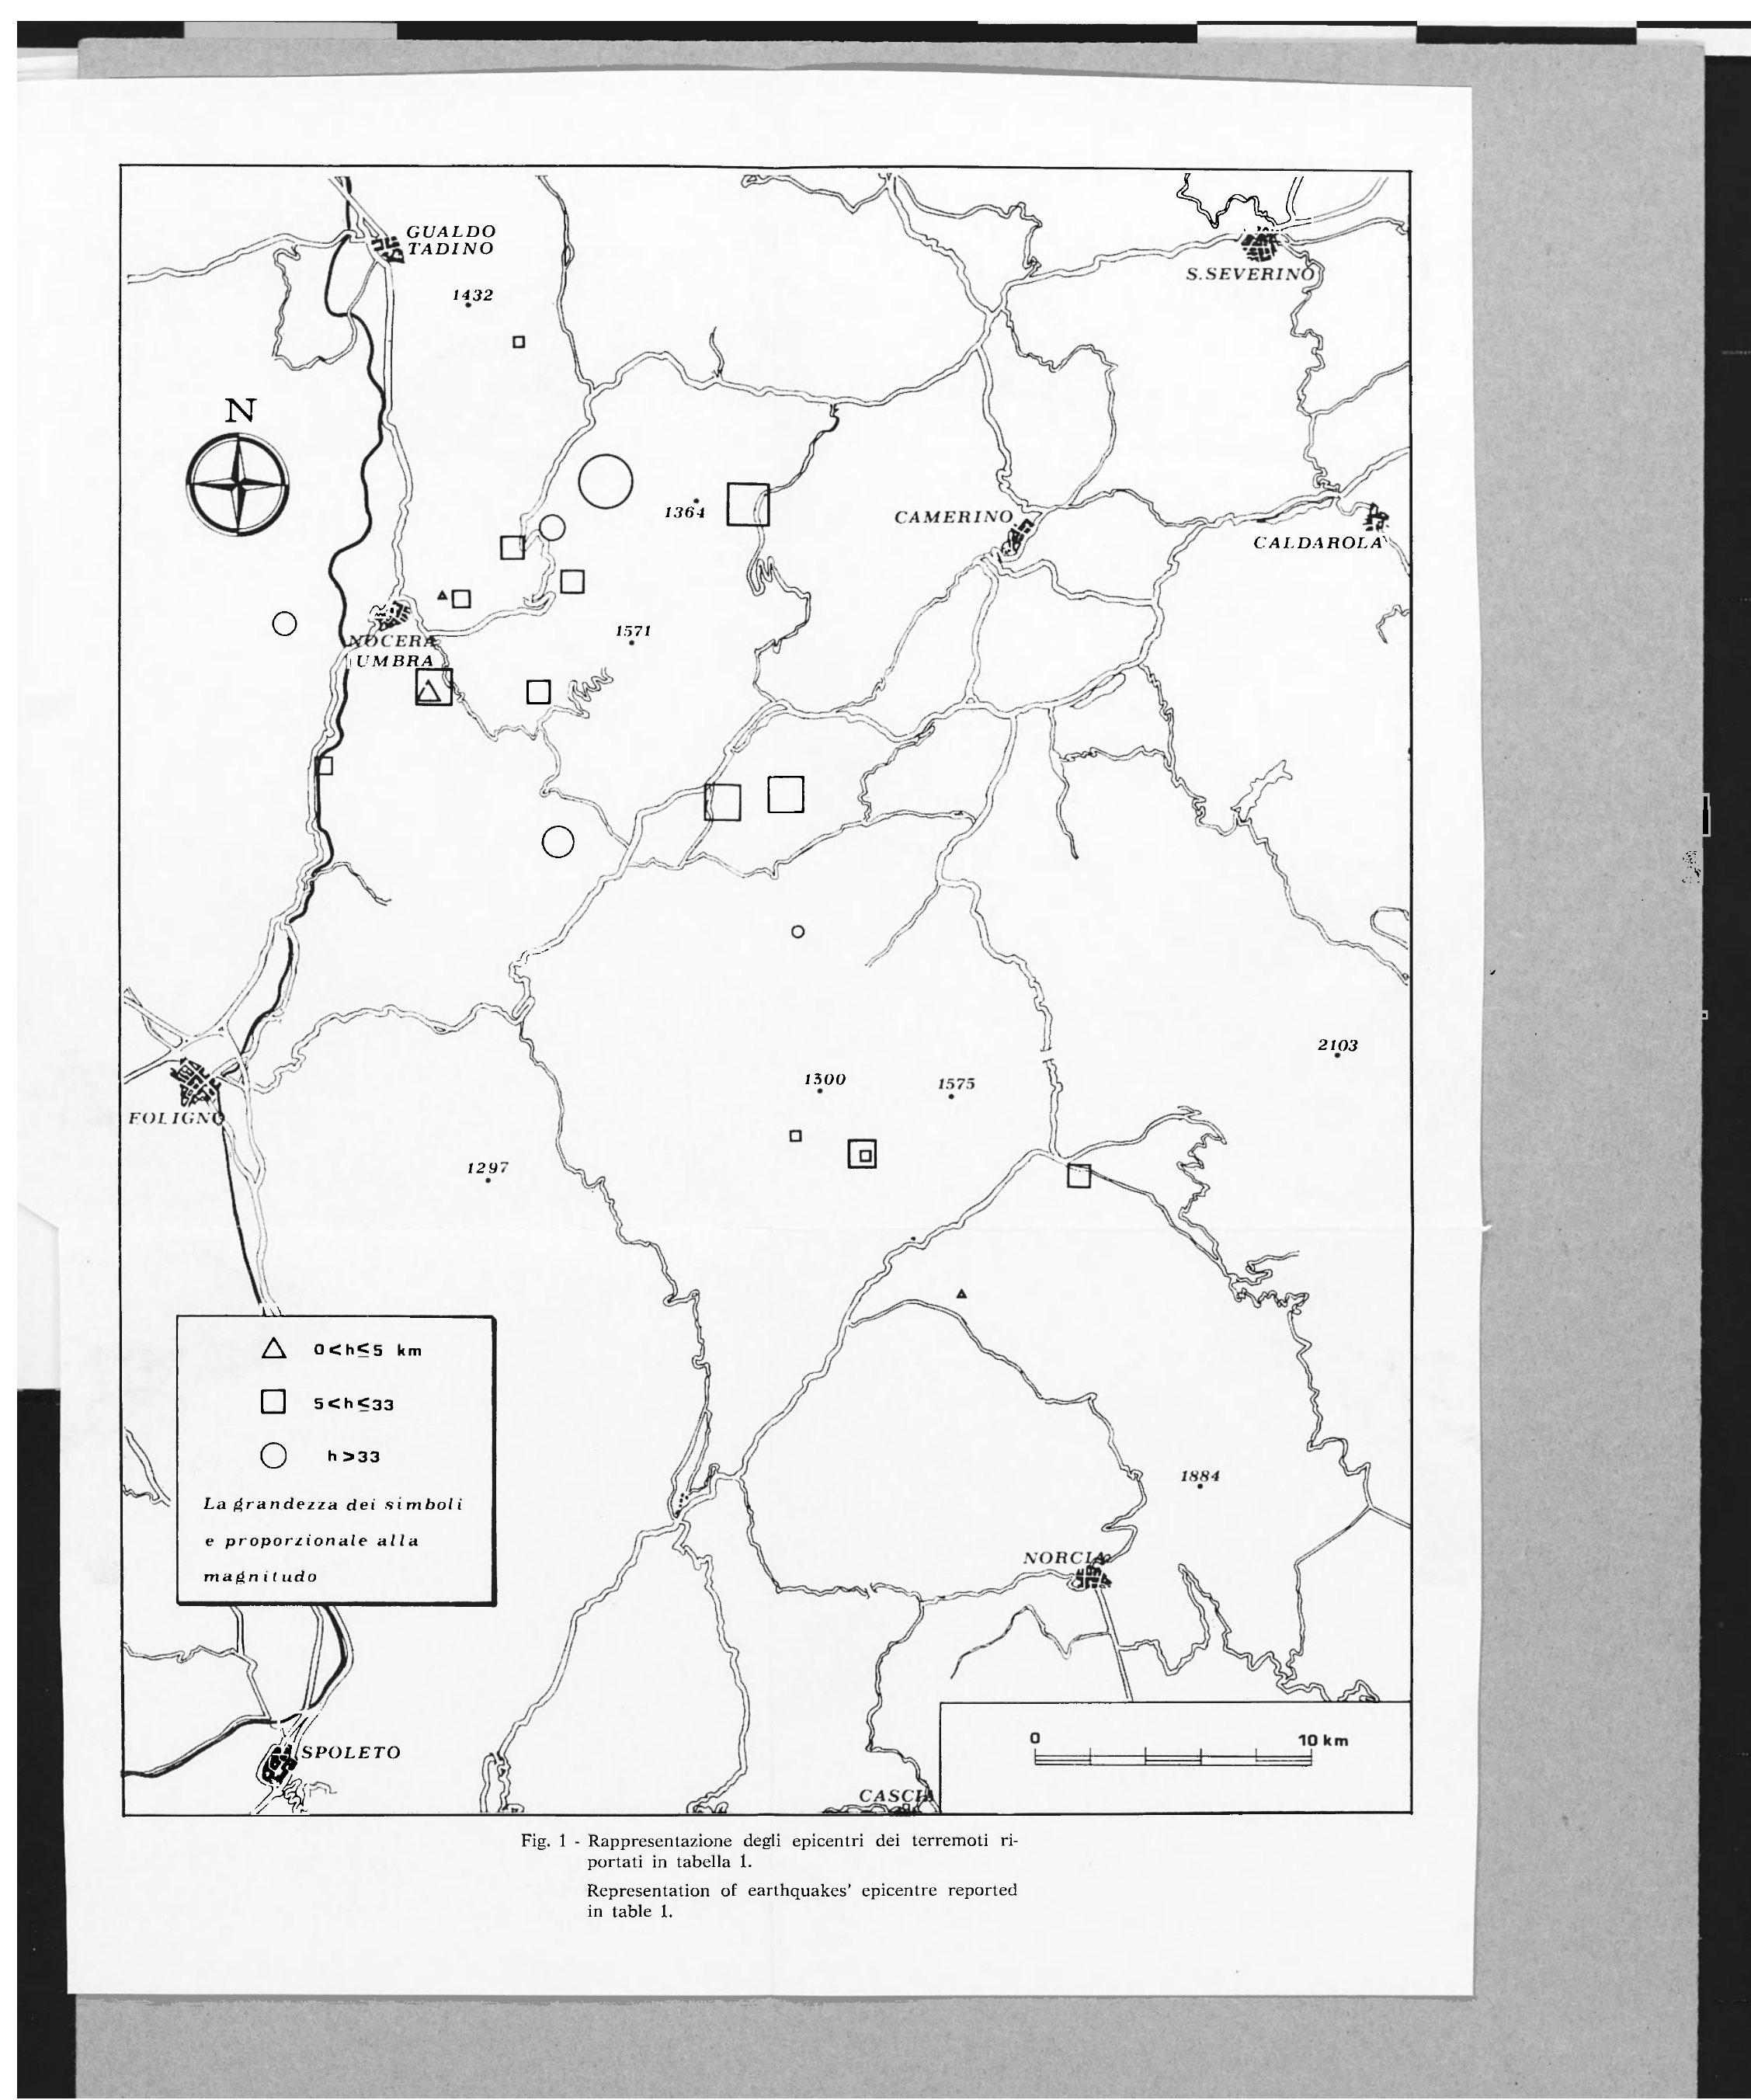
Fig. 1 - Rappresentazione degli epicentri dei terremoti ri- portati in tabella 1. Representation of earthquakes' epicentre reported in table